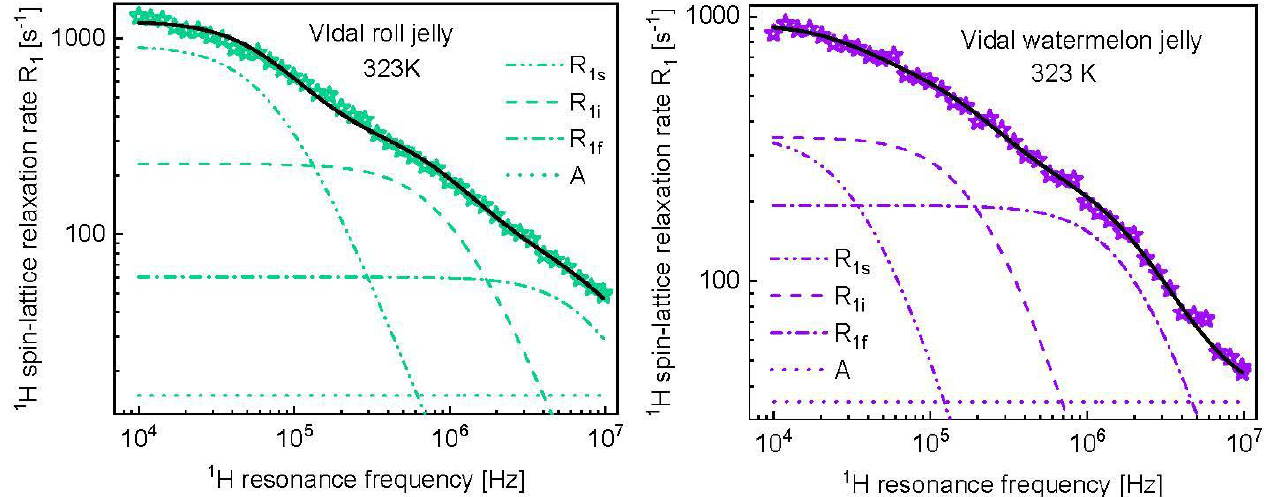
Figure A3. 1 H spin-lattice relaxation data for Vidal roll jelly ( right ) and Vidal watermelon jelly ( left ) at 323 K reproduced in terms of the model described in the theory. The fit ( R 1 ) shown as a black solid line has been decomposed into relaxation contributions associated with slow, intermediate and fast dynamics, R 1s , R 1i and R 1f , respectively. The frequency independent term, A, is also indicated.